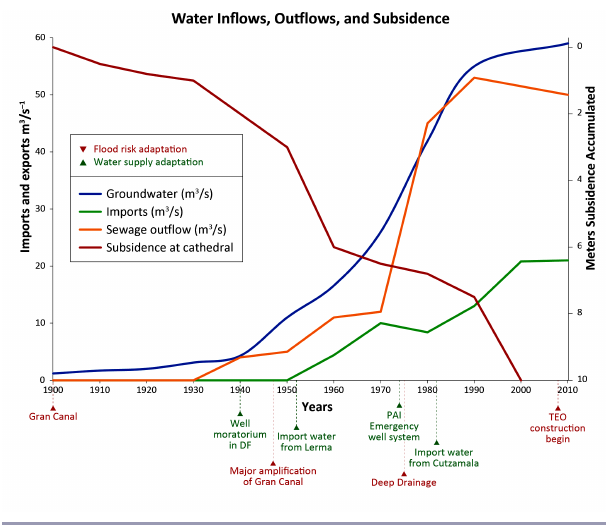
Fig. 4 . Water pumping, imports, exports, and subsidence rates from 1900-2010 with key flood (red arrows) and water supply (green arrows) adaptation interventions. Sources: Durazo and Farvolden 1989, Marsal 1992, Ezcurra et al. 1999, Romero Lankao 2010, Aguilar-Barajas et al.